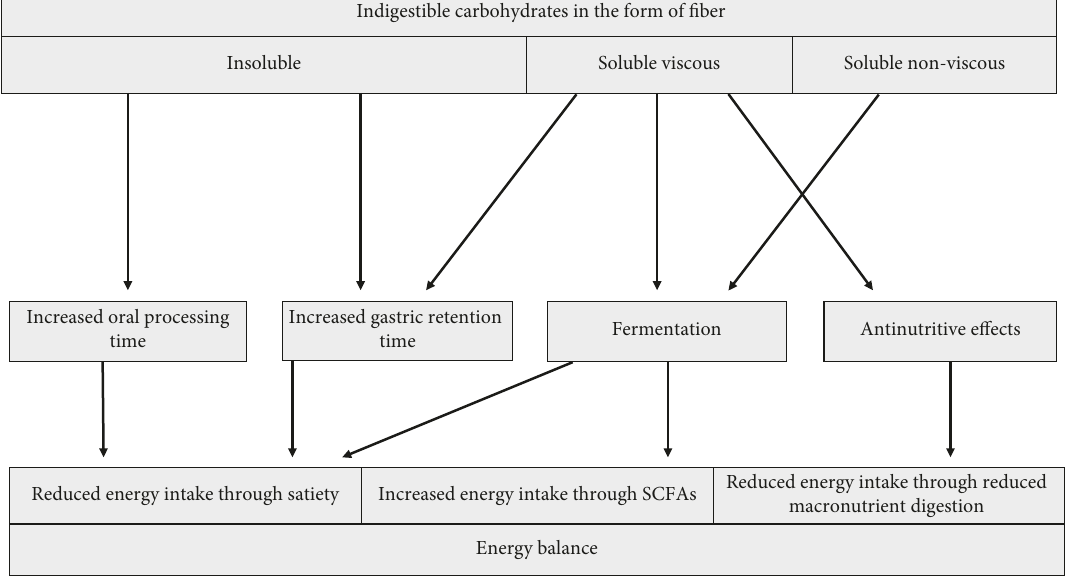
Figure 1: Potentially important mechanisms for fiber effect on energy balance. The size of boxes and arrows are arbitrary and are not indications of